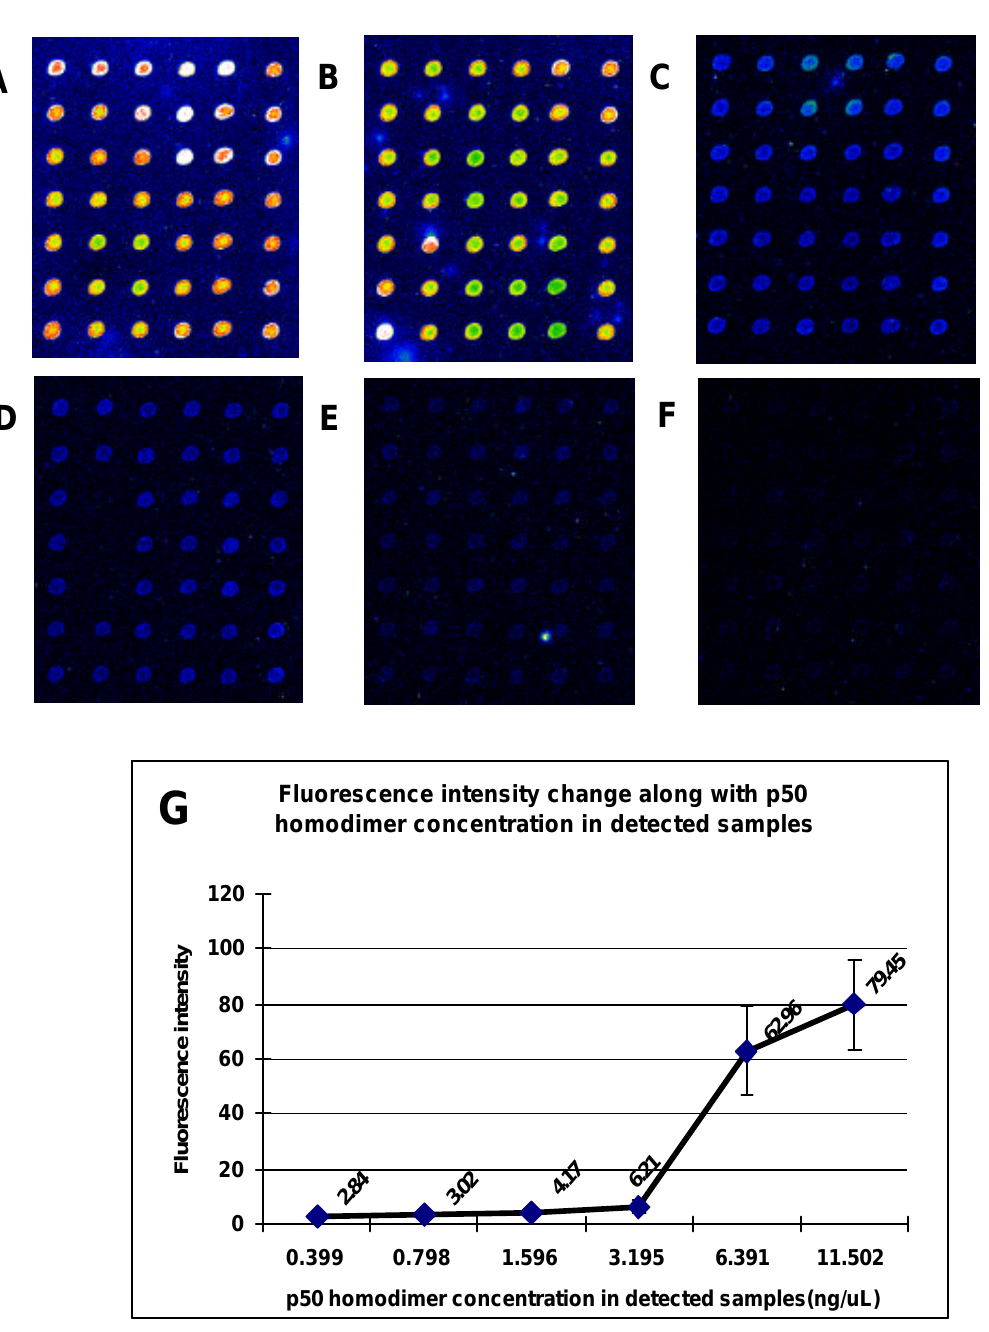
Figure 6. Fluorescence images and intensity plot of 6 dsDNA microarrays containing 6×7 NF- k B TOs which were hybridized with 6 variant binding reactions containing different concentrations of Cy3-labeled NF- k B